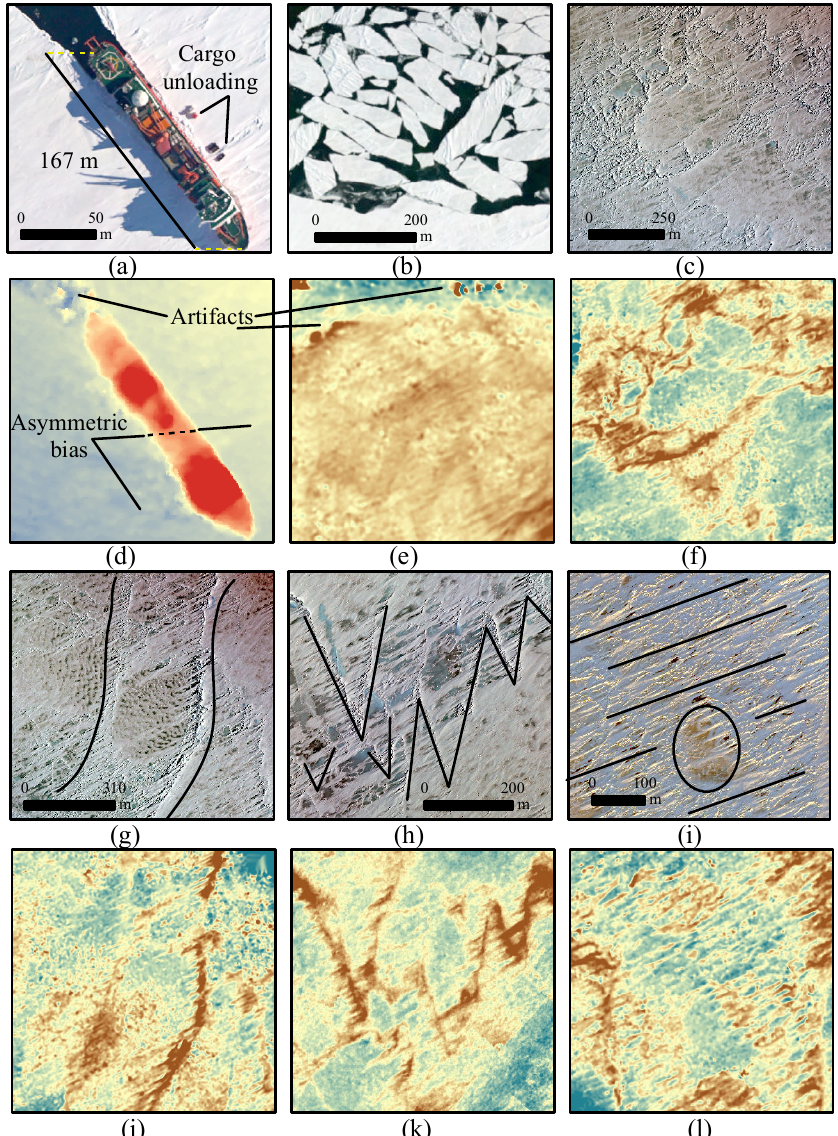
Figure 11. The typical surface geometric features selected from the orthomosaics and their corresponding local surface topography: ( a ) The anchored R/V Xuelong, with cargo unloading nearby. ( b ) Newly-broken chunks of ice floes close to the outer boundary of the landfast ice (lower part). ( c ) Extremely rough margin close to the outer boundary of the landfast isce (upper part). ( d – f ) are their upper panels’ corresponding surface elevation. Please note the unbalanced bias acting between the two flanks of the R/V Xuelong in ( d ), and little artifacts in the area of sea water in ( e ). ( g ) Two almost parallel and smoothly curved ice ridges, with melting pond-like features interspersed nearby. ( h ) Ice ridges in an opposing zigzagged shape. ( i ) Densely distributed and nearly parallel snow dunes with a flat ice floe inside. ( j – l ) are their upper panels’ corresponding surface elevation. Note that all the orthomosaic and surface elevation images are locally stretched to enhance the visualization. Please refer to boxes in Figure 4 for all panel’s geographic